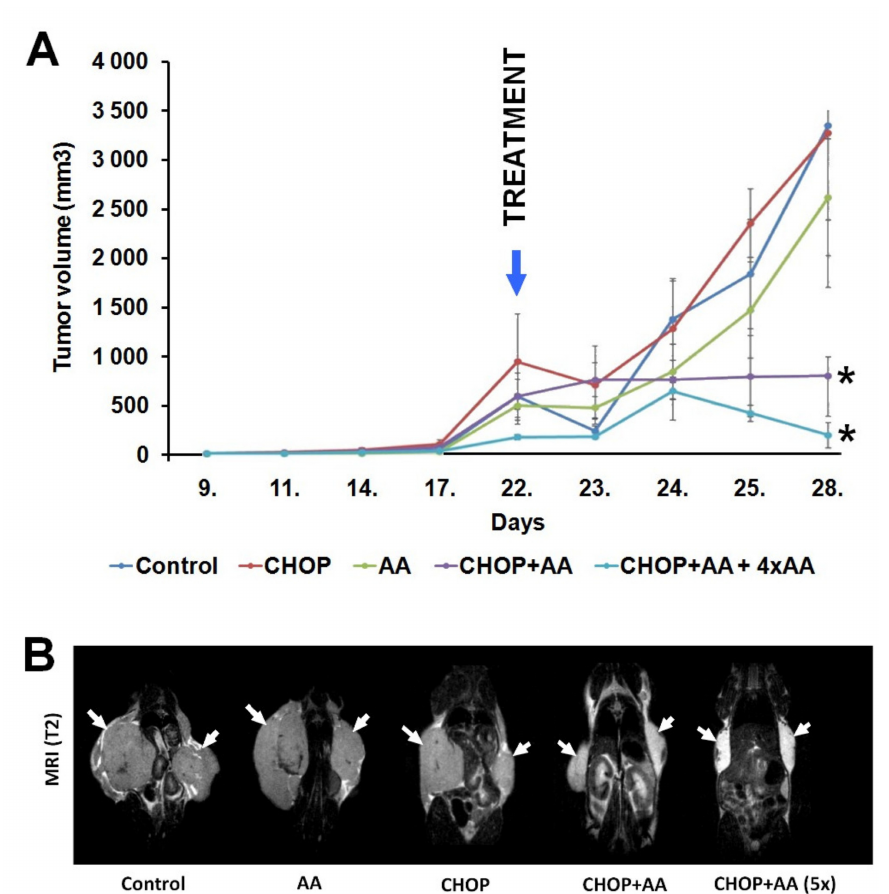
Figure 2. ( A ) Dynamics of the A20 tumor volume (mm 3 ) in the di ff erent treatment groups. Control, CHOP and AA groups show a massive extension after day 23. In contrast, suppression of tumor growth was observed in the groups CHOP + AA and CHOP + AAx5. Significance level: p ≤ 0.05 (*) between the AA containing treatments and untreated or not AA containing treatment tumors at day 28. n = 3 mice / group; n = 2 A20 tumors / mouse. ( B ) Representative coronal T2-weighted MR images of A20 tumor-bearing mice at day 28. White arrows: A20